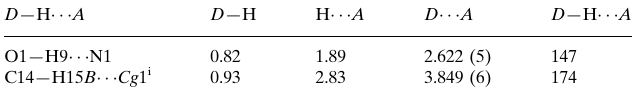
Hydrogen-bond geometry (A˚ , (cid:2) ). Cg 1 is the centroid of the C1–C6